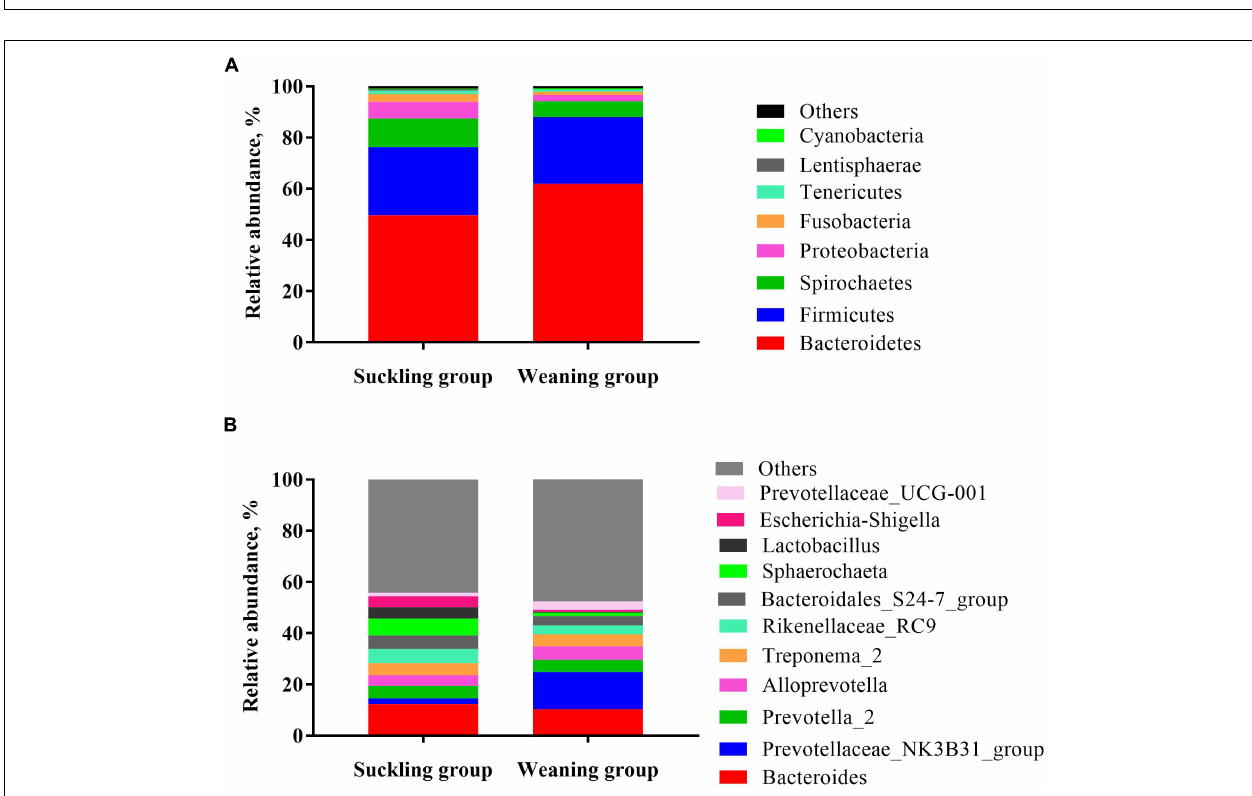
FIGURE 3 | Taxonomic classification of the 16S rRNA gene sequences at the (A) phylum and (B) genus levels for the suckling and weaning group.